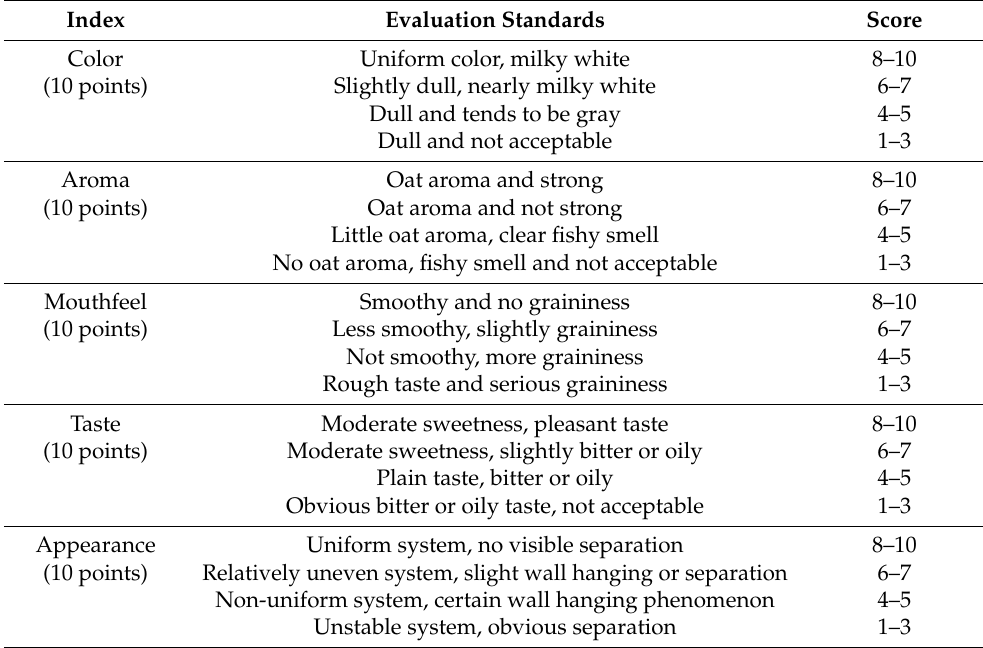
Table 1. Criteria for sensory evaluation of oat